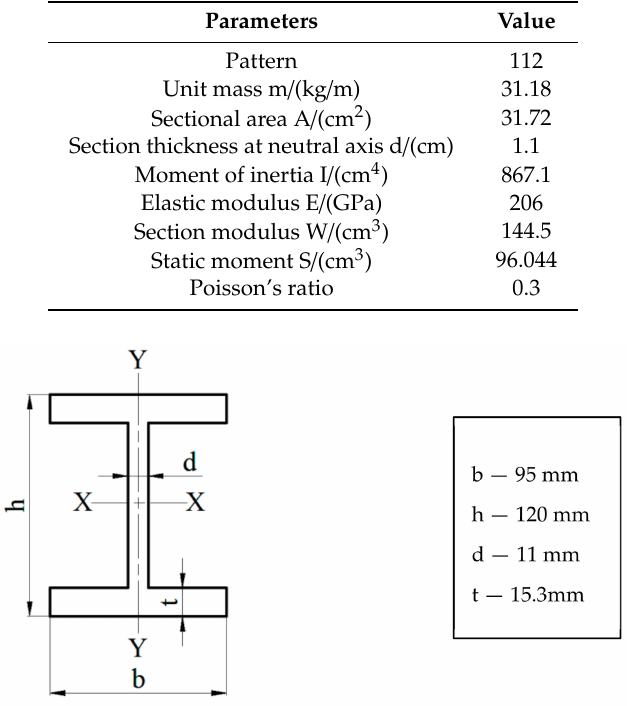
Figure 3. Cross section of the 12H